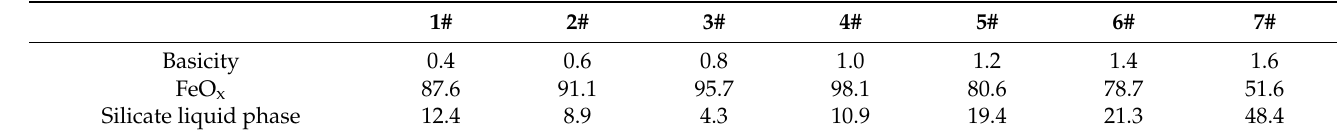
Table 7. The fraction of FeO x and Silicate liquid phase.